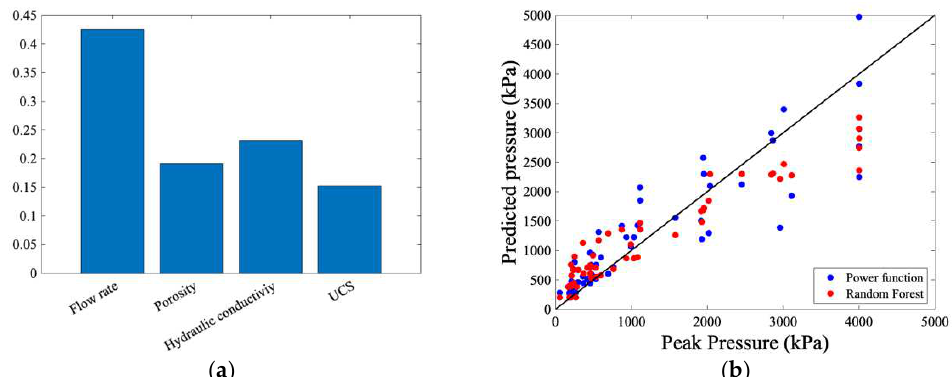
Figure 13. ( a ) Input parameter importance as determined by the random forest algorithm; ( b ) pre- dicted Vs. actual peak pressure for the power function fit and the random forest algorithm.